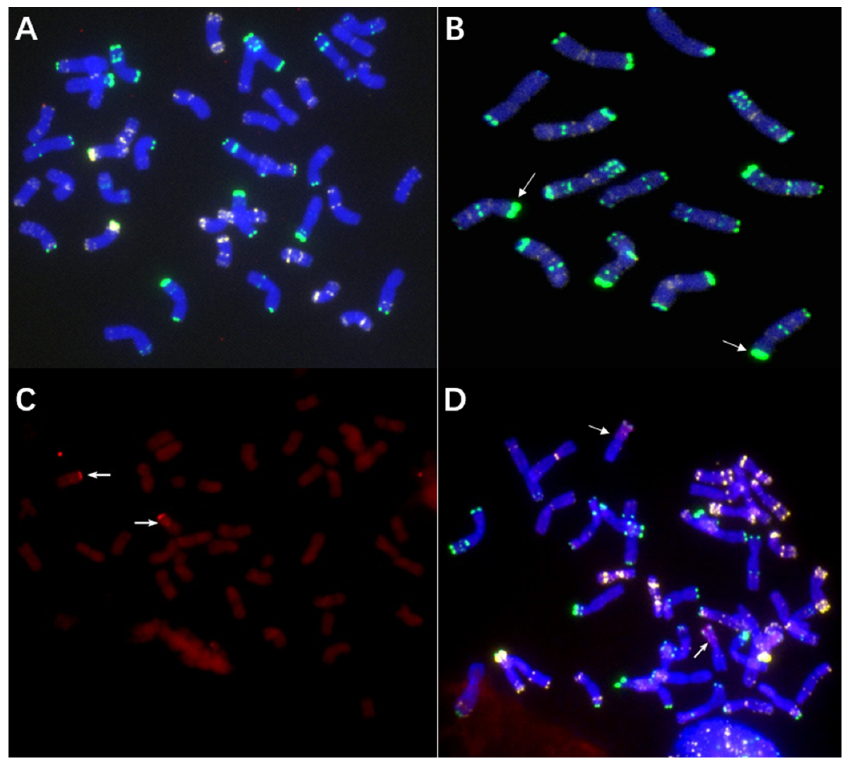
Figure 2. Cytogenetic identification (600x) of the T6RS.6AL translocation line 117-6. ( A ) Chromosome structure of CN25. No rye chromatin was found. ( B ) Chromosome structure of Qinling rye. The arrows show the strong signal patterns of the distal region of 6RS. ( C ) GISH results of 117-6; the arrows show the translocation chromosomes. ( D ) ND-FISH results of 117-6. The arrows show the T6RS.6AL translocation chromosomes. Oligo-pSc119.2-1: green, Oligo-pTa535-1: white, Oligo-Ku, Oligo-pSc200, and Oligo-pSc250: red. The wheat chromosomes were blue in A, B, D, and dark red in C. The rye chromosomes were bright red in C.